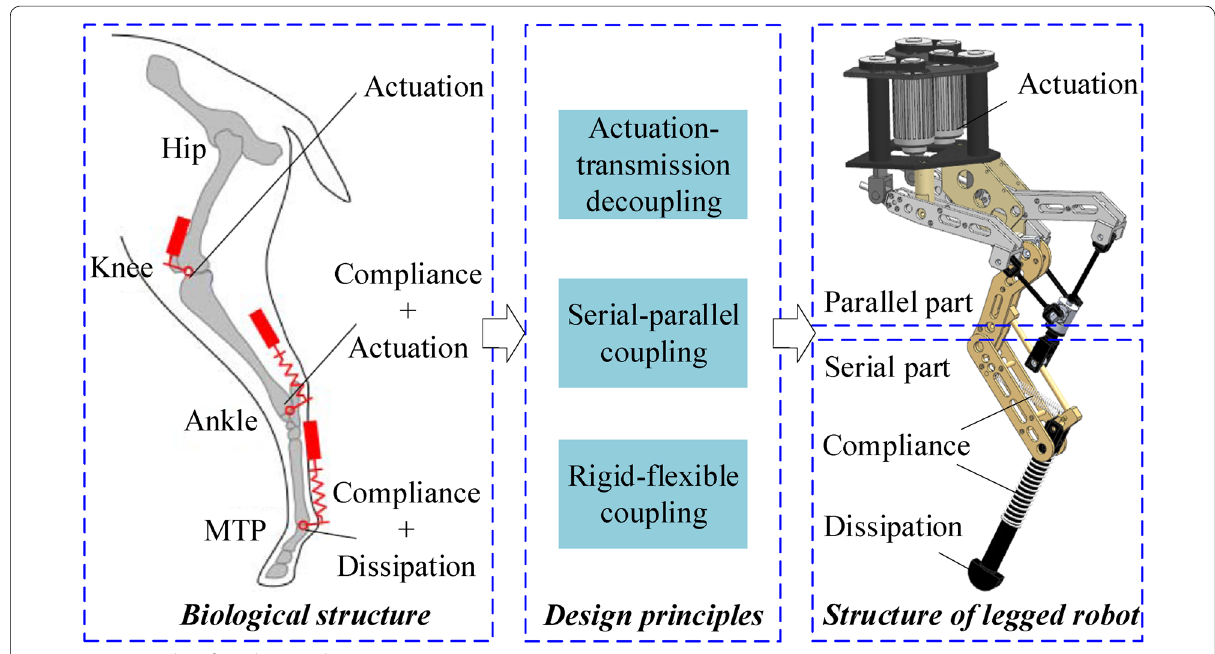
Figure 23 Principles of mechanism